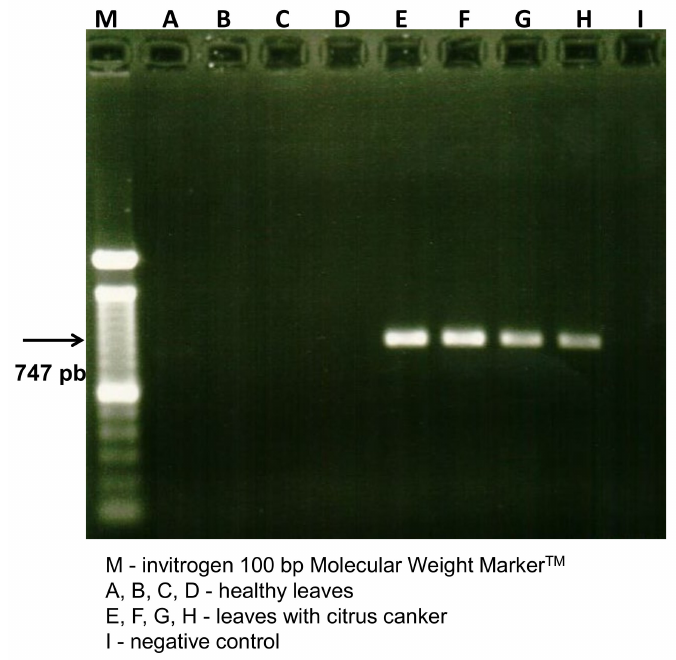
Figure 1. Diagnosis of citrus canker by PCR detection of Xcc in orange leaf samples characterized by the amplification of the 747 bp fragment. Four healthy leaves and four citrus canker leaves were used in the